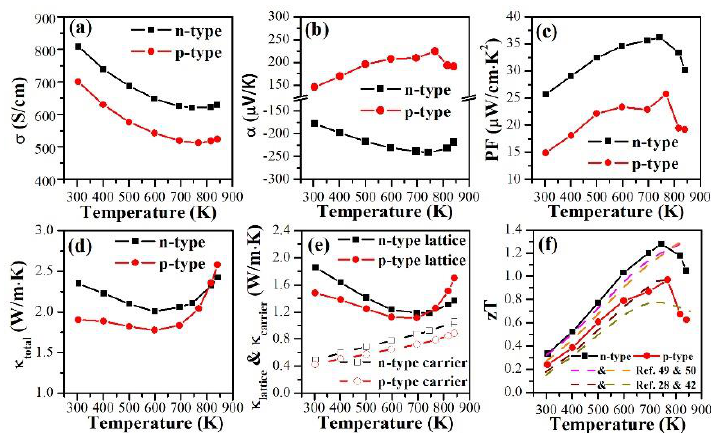
Figure 4. Summary of the thermoelectric (TE) properties. ( a ) electrical conductivity, ( b ) Seebeck coefficient, ( c ) power factor, ( d ) total thermal conductivity, ( e ) lattice and carrier thermal conductivity, and ( f ) zT for n-type Yb 0.25 Fe 0.25 Co 3.75 Sb 12 and p-type La 0.7 Ti 0.1 Ga 0.1 Fe 2.7 Co 1.3 Sb 12 materials. The dashed line data are from References [28,42,49,50].